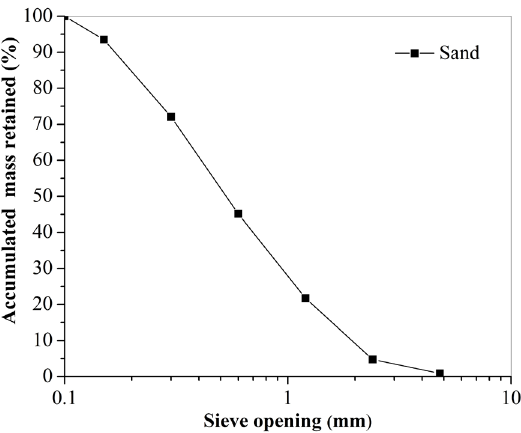
Figure 3. Particle size distribution of sand.